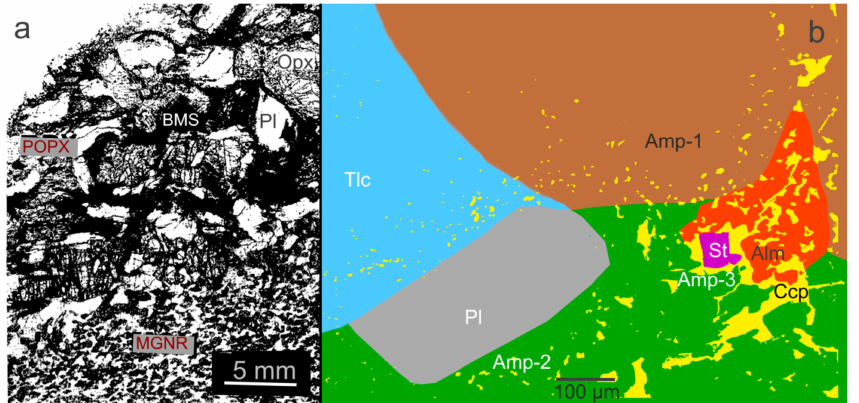
Figure 12. ( a ) Shows an example of pegmatitic gabbronorite grading to plagioclase-bearing orthopy- roxenite (POPX) observed in polished section, cf. [27]. This rock, highly enriched in Pd-Pt-(Ag), is composed of orthopyroxene (Opx), plagioclase (Pl), and base-metal sulfides (BMS) of the chalcopyrite- (Ccp)-bornite-millerite assemblage. The POPX rock is hosted by a sill-like body of microgabbronorite, MGNR, which is present in direct contact in ( a ). ( b ) is a false-color image displaying, schematically, the previously reported occurrence [27]. Grains of talc (Tlc) and an anthophyllite-related amphibole (Amp-1) formed as a result of deuteric alteration at the expense of igneous orthopyroxene (En 75–77 ). The peraluminous assemblage includes alumino- and chlorian varieties of tschermakite (Amp2 and 3, respectively), an almandine garnet (Alm), and a tiny grain of staurolite (St). These minerals of the Al-rich assemblage are intimately associated with a large grain of late-magmatic plagioclase: An 63